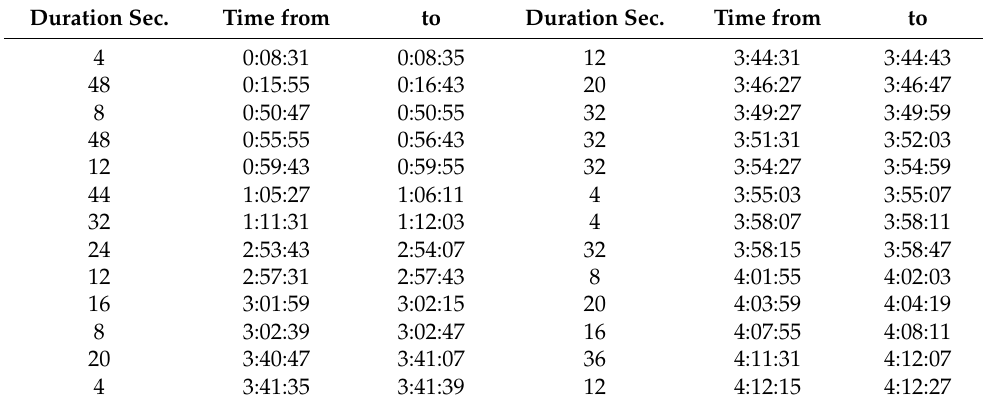
Figure 2. Night sleep of the patient with acute pneumonitis until shortly after 4:00 a.m. without oxygen supply, then with oxygen supply 1.5 L/min. Table 1. Reaching and falling below the threshold value 1 of oxygen concentration in the blood during night sleep according to Figure